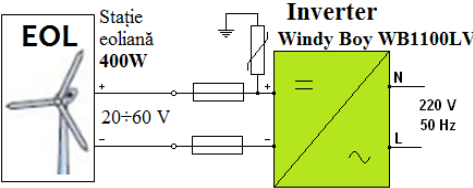
Figure 7. Block diagram of Subsystem 3 connected to the grid.